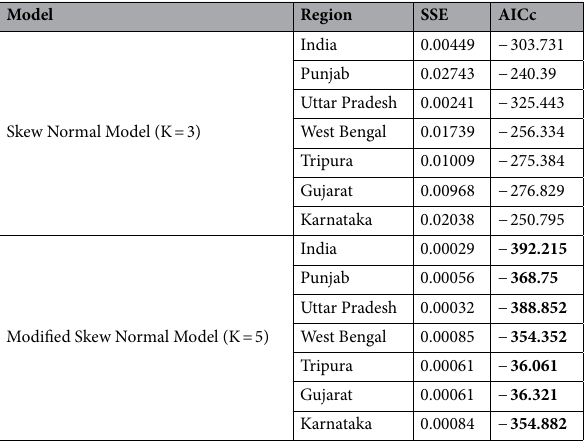
Table 4. Minimized sum of square (SSE) and AICc values under Skew Normal Model and Modified Skew Normal Model for India and 6 selected states. The least value of AICc is written in the bold case for each state.